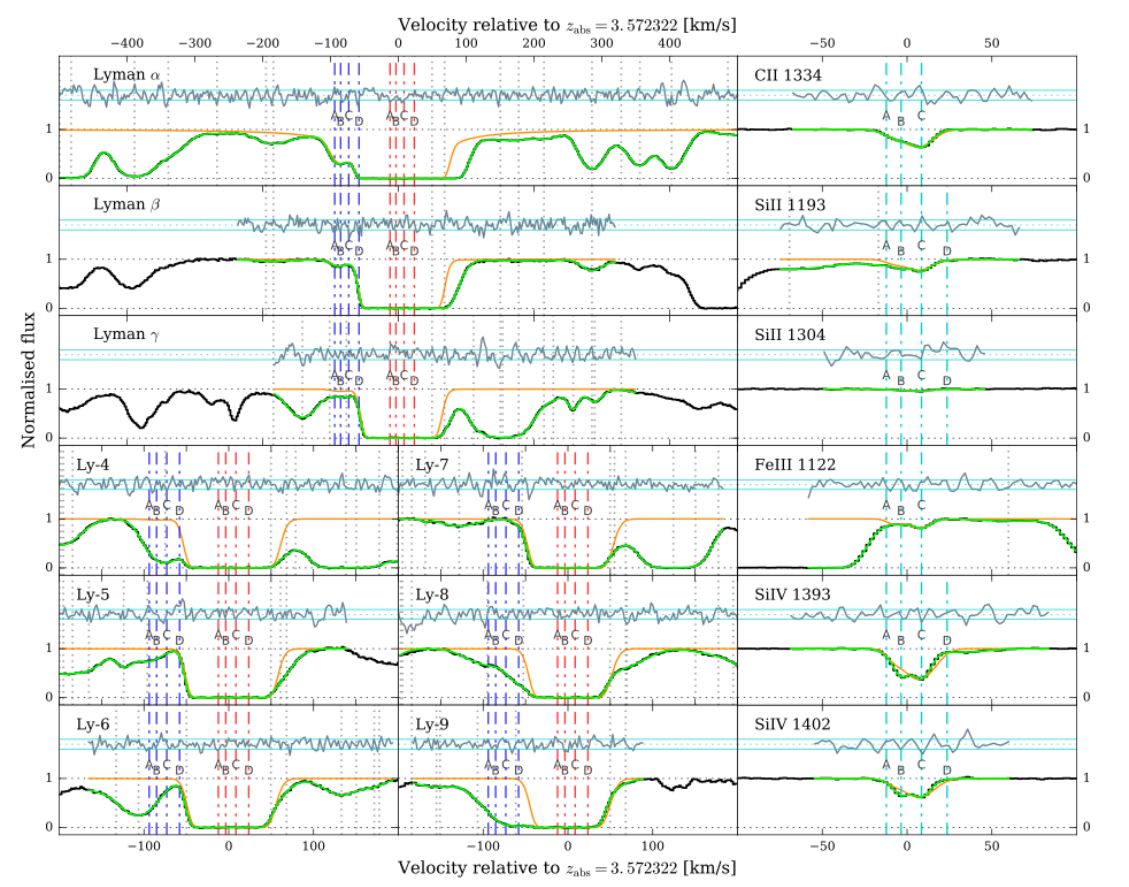
Figure 3. The normalised stacked flux spectrum (thick black) of the z abs = 3.572 absorber, and the best fit model (green), as well as the normalised fit residuals (above each fit). The stacked spectrum is only used for visualisation, as the model fitting is always performed on the individual spectra simultaneously. The fitted velocity components are marked by vertical dot-dashed lines denoted by A to D (HI in red, DI i in blue, metals in cyan), and interloping HI lines are shown as vertical dotted lines (light grey). The model from Tytler et al. [5] (without blends) is over-plotted in orange, illustrating the difference between the derived model structures, particularly for the metals. Figure from